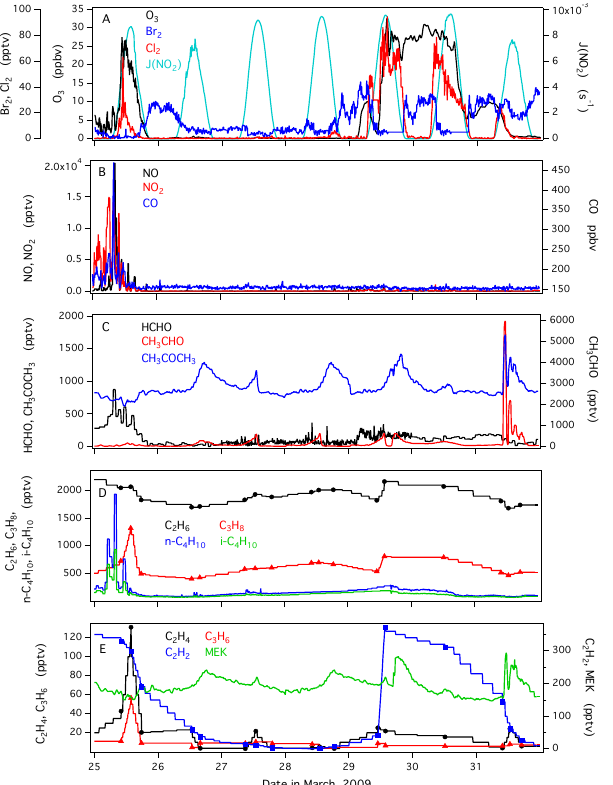
Figure 1. Ambient measurements of O 3 , Cl 2 , Br 2 , NO 2 , NO, CO, VOCs, and OVOCs that are incorporated into the model. Mixing ratios for the NMHCs that were collected as canister samples were interpolated between samples. Available canister sample data points are indicated on their respective plot. The photolysis rate coefficient ( J ) is shown for NO 2 as an example in Panel (a) . Time is expressed in Alaska Standard